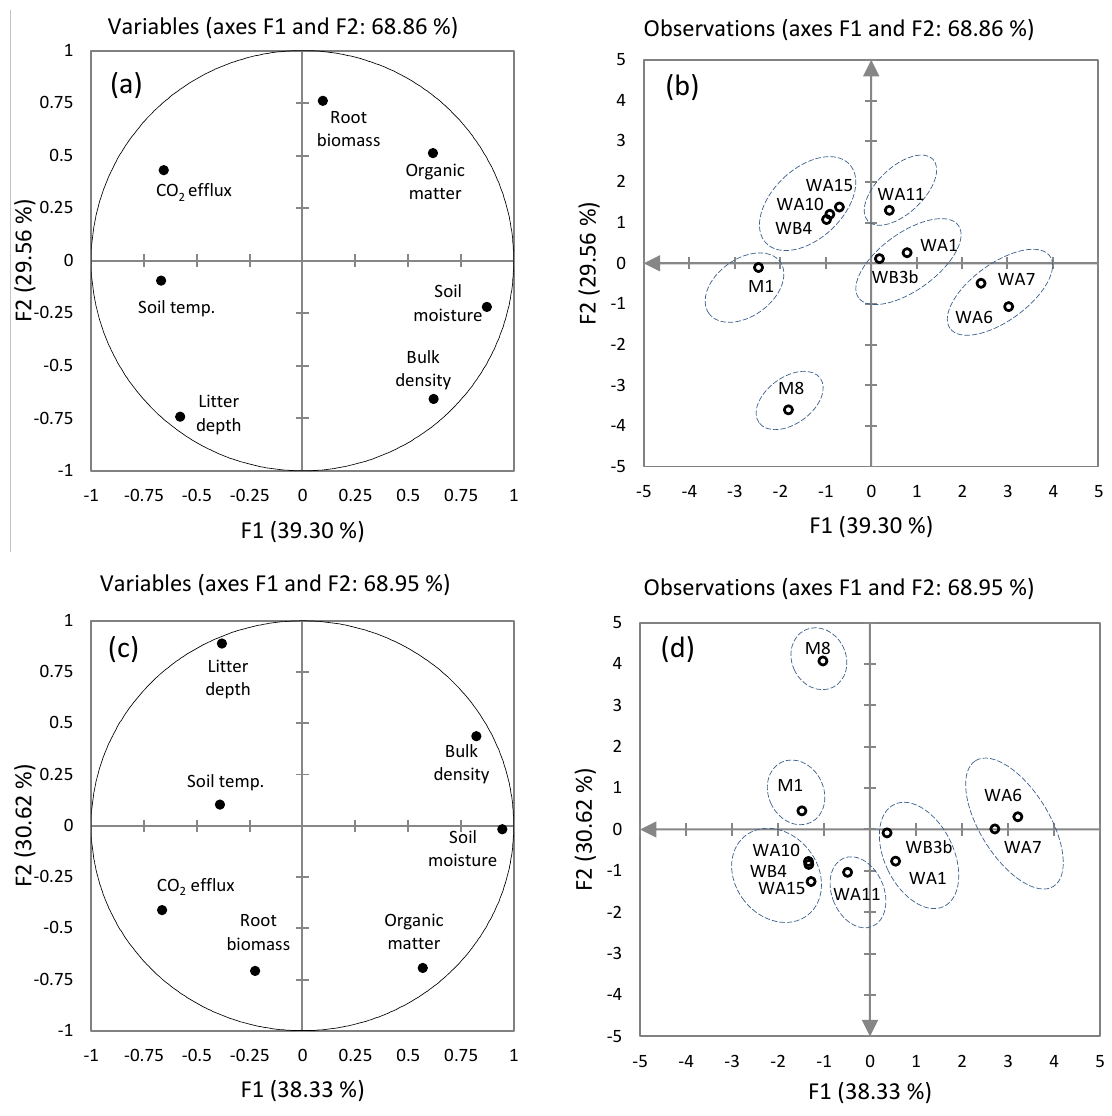
Figure 3. Multiple factor analysis (MFA) based on seasonal means of observed variables from 2011 to 2012. (a) and (c) are the correlations between variables and factors over spring and summer, respectively; (b) and (d) are the dependence of measurement sites on the factors and clustering over spring and summer,